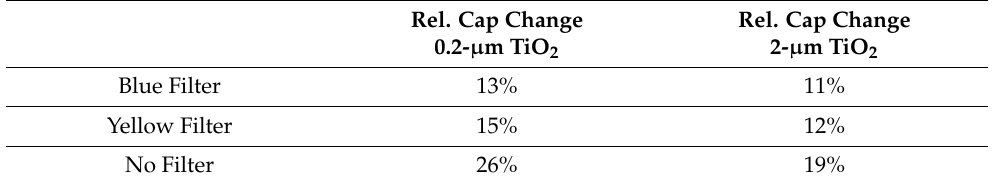
Table 3. Relative capacitive change using a C-V measurements in a 3-electrode setting when illumi- nated by a 75 W white-light source.